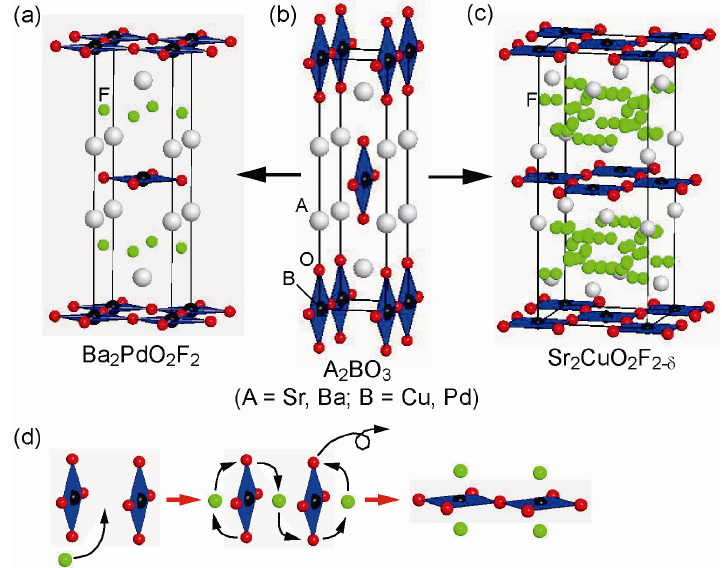
Figure 8. ( a ), ( b ), ( c ) Fluorination of A ( d ) Rearrangement of oxide and fluoride anions during fluorination